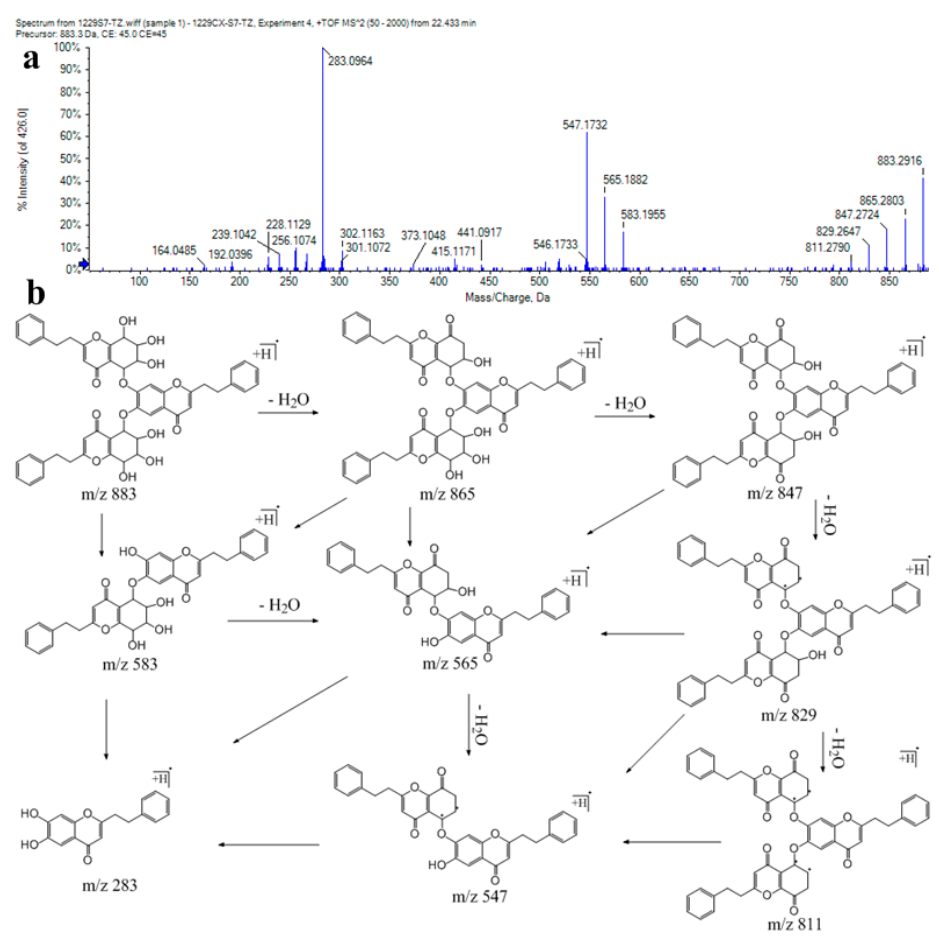
Figure 5. ( a ) MS/MS spectrum of compound 139; ( b ) proposed fragmentation pathway of compound 139.